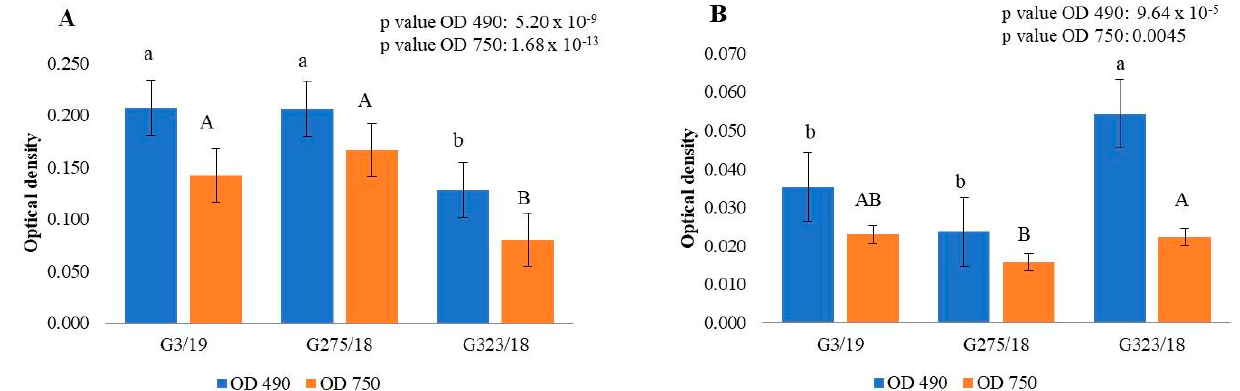
Figure 2. Optical density values from the MT2 microplates for the three different strains of B. cinerea in function of FF inoculating fluid ( A ) and PDB medium ( B ). Each value is represented with the standard error. The lower-case letters (referring to the 490 nm optical density) and the upper case letters (for the 750 nm optical density) represent the results obtained after applying the post hoc Wilcox test (Tables S1, S2, S4, S5, S7, S8, S10 and S11).